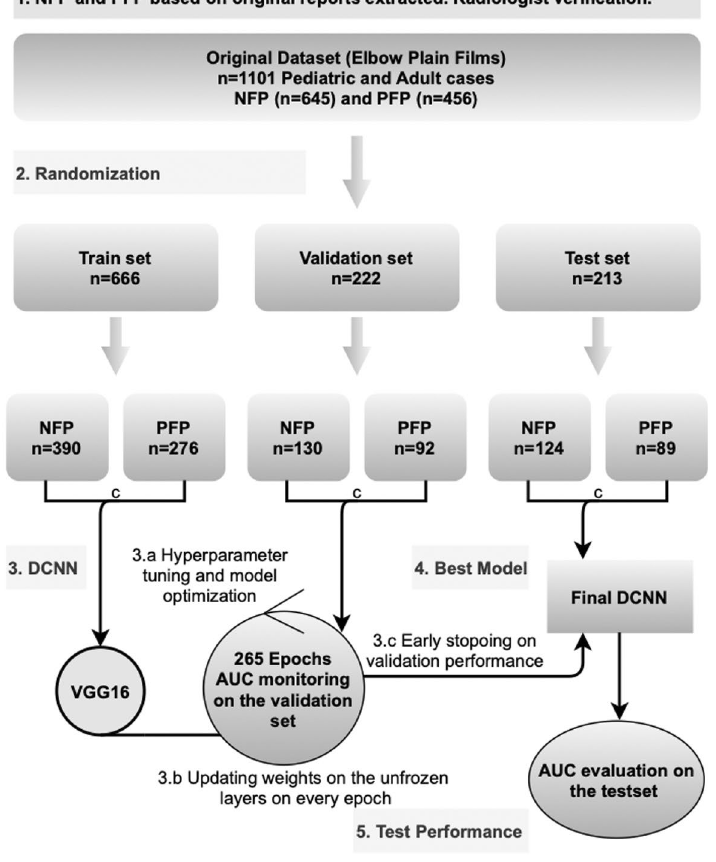
Figure 2. AI study method diagram. NFP = Negative Fat Pads/joint effusion; PFP = Positive Fat Pads/joint effusion; DCNN = Deep Convolutional Neural Network; ROC = Receiver Operating Characteristic; AUC = Area Under the